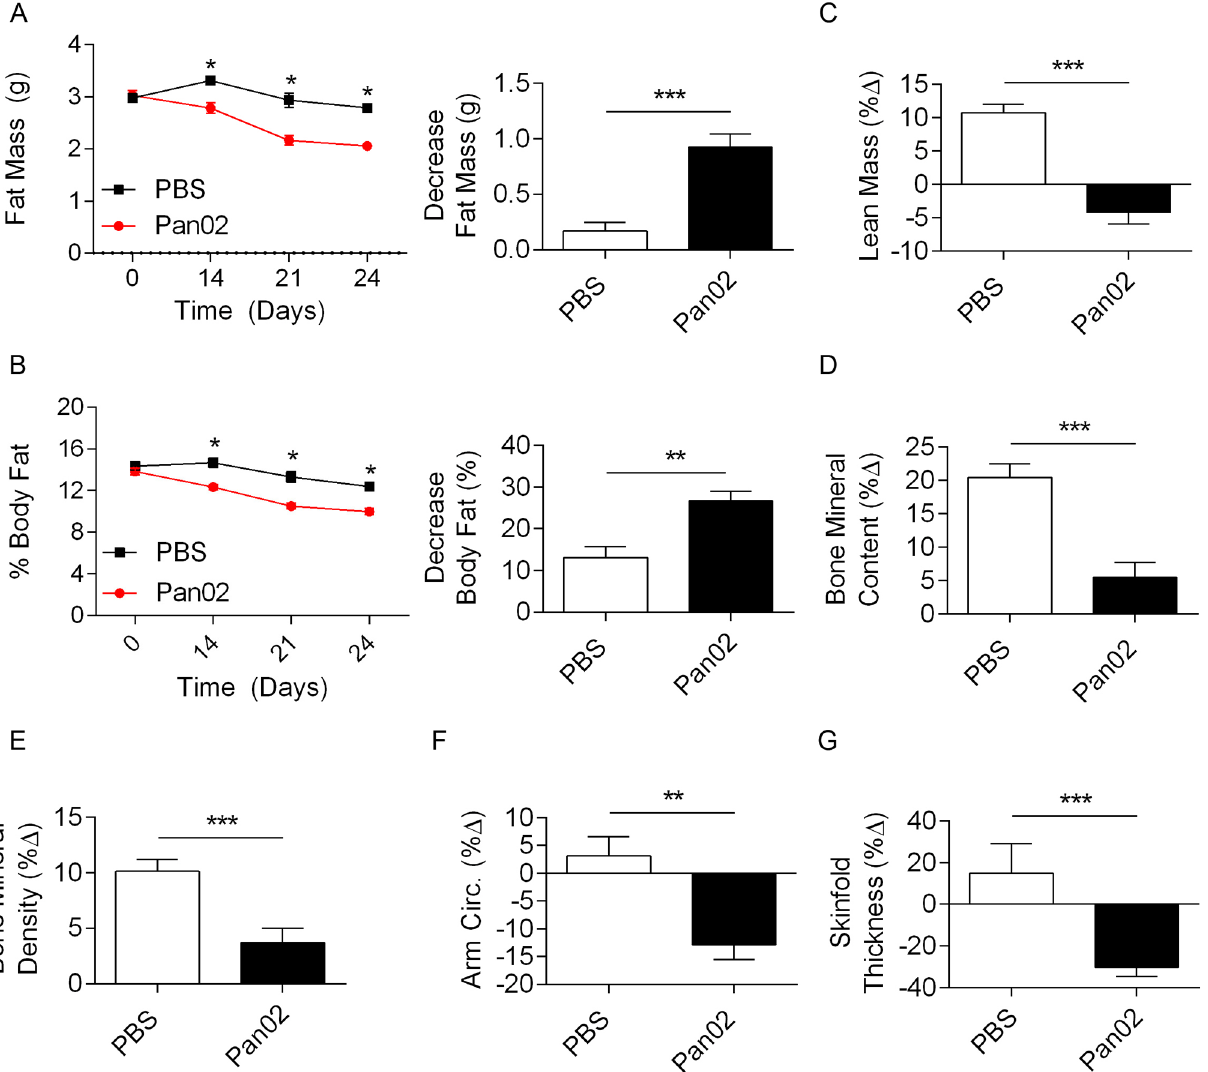
Fig 2. Mice challenged with Pan02 developed evidence of cachexia based on body composition. (A) Average fat mass B) and average percent body fat of mouse cohorts treated with PBS or Pan02 was calculated at various time points as well as total change over the course of the study. (C) Changes in lean mass, (D) bone mineral content, (E) bone mineral density, (F) arm circumference, and (G) skinfold thickness were also calculated (n = 20; * p < 0.05, ** p < 0.01, *** p < 0.001).